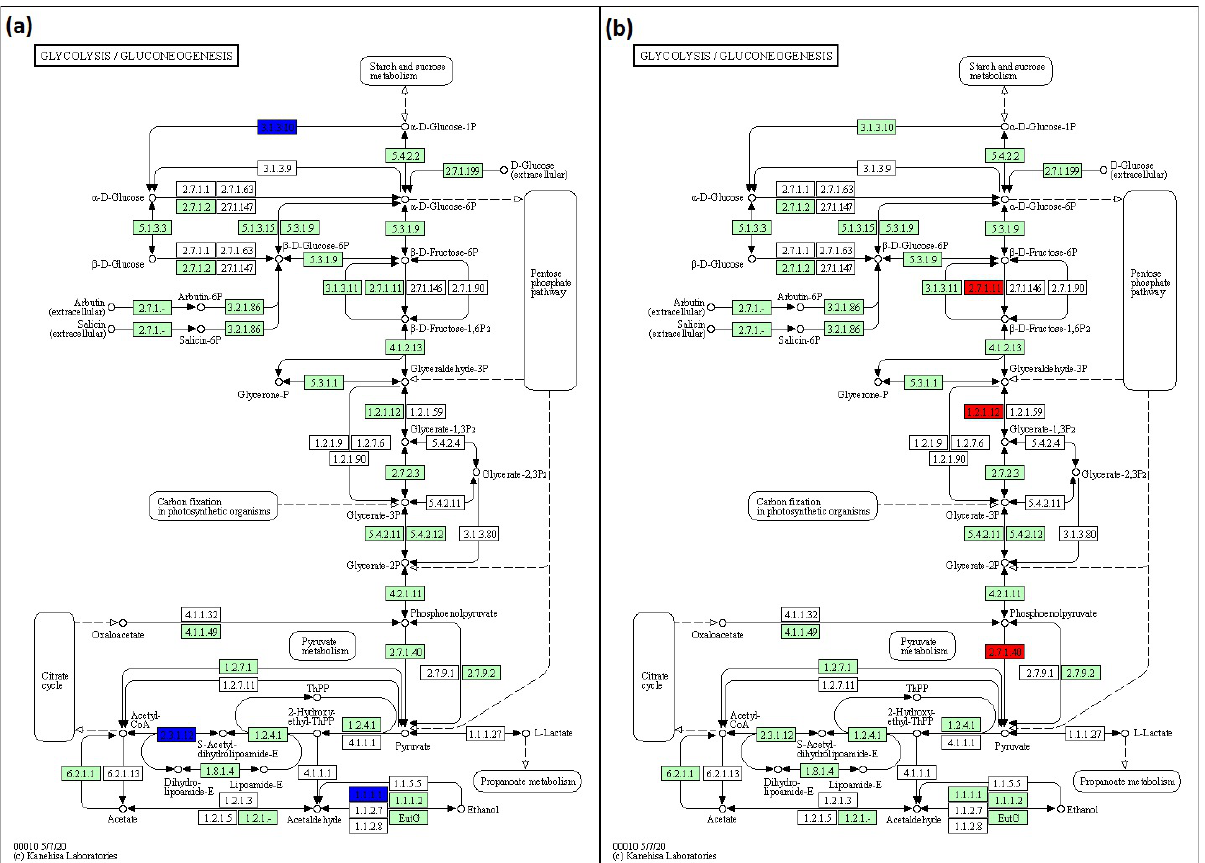
Figure 7. KEGG pathway maps for predicting pathways influenced by the lack of ( a ) rfaC and rfaG , and ( b ) rfaL OMV genes in E. coli BW25113. This pathway is produced using KEGG Mapper online software (https://www.genome.jp/kegg/mapper/color.html; accessed on 28 December